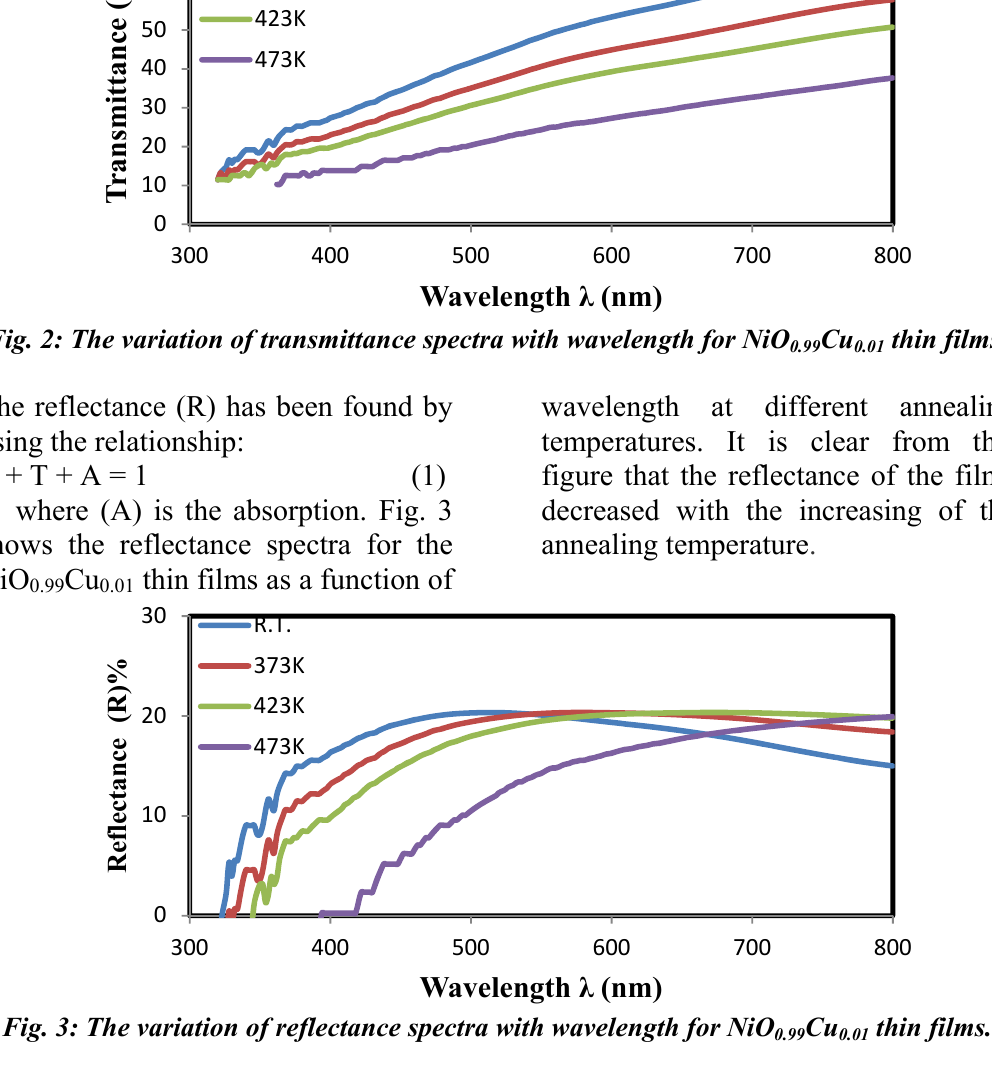
Cu thin 0.99 0.01